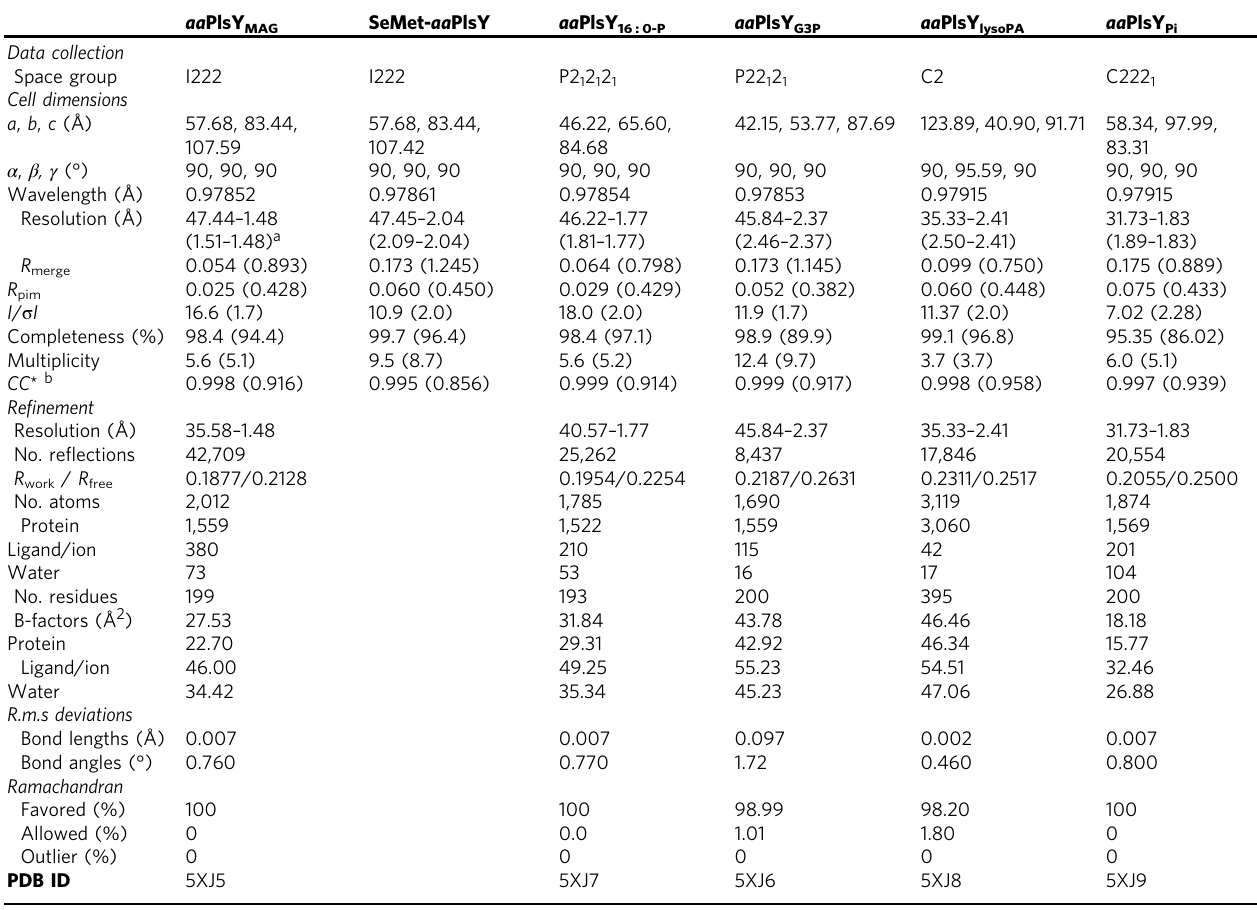
Table 1 Data collection and re fi nement